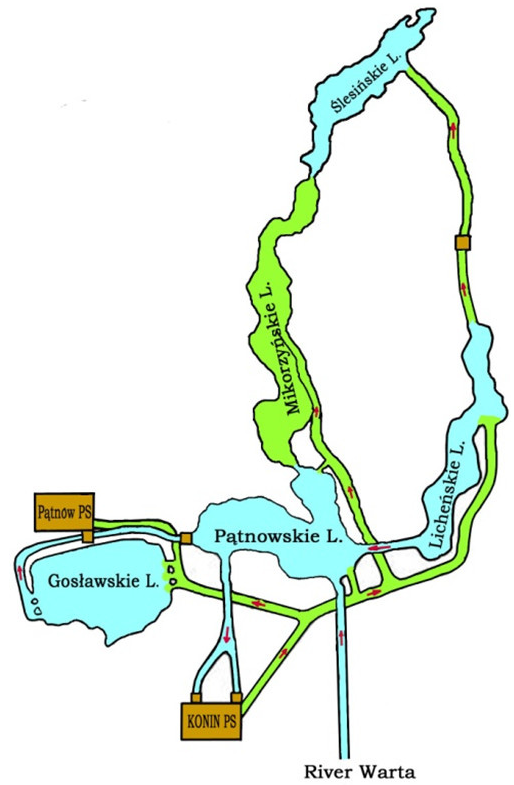
Figure 1. Scheme of the cooling system of the Konin Lakes. Explanation: colours mark intake to (blue) and discharge from (green) power stations.